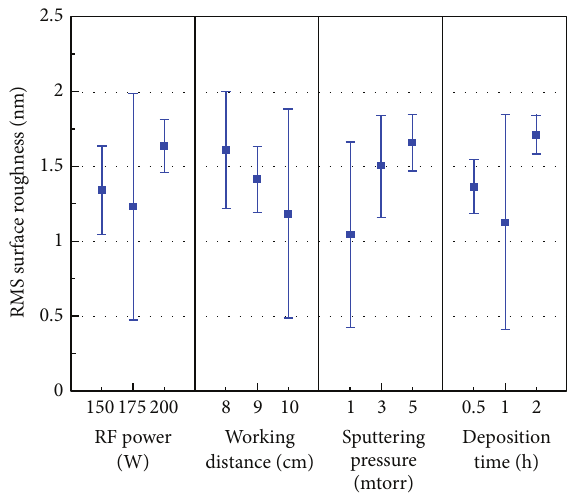
Figure 6: Response graph of four factors versus contact angle. The ranking of the order of the magnitude of the contact angle differs at various levels, indicating that the effects of various factors on the contact angle increasing in accordance with RF power, deposition time, working distance, and sputtering